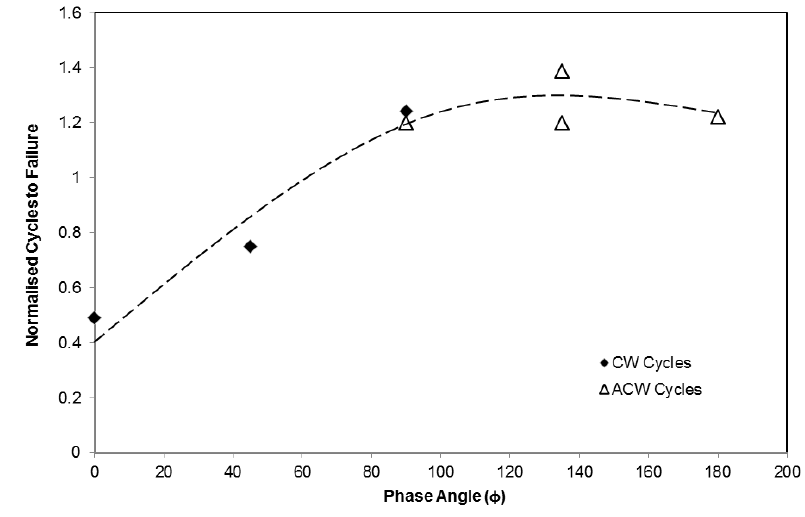
Figure 5. Phase angle (ϕ) vs . number of thermo-mechanical fatigue (TMF) cycles to failure ( N ) for constant strain range (Δε) of f